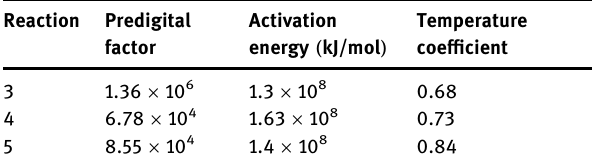
Table 2: Chemical kinetics parameters Reaction